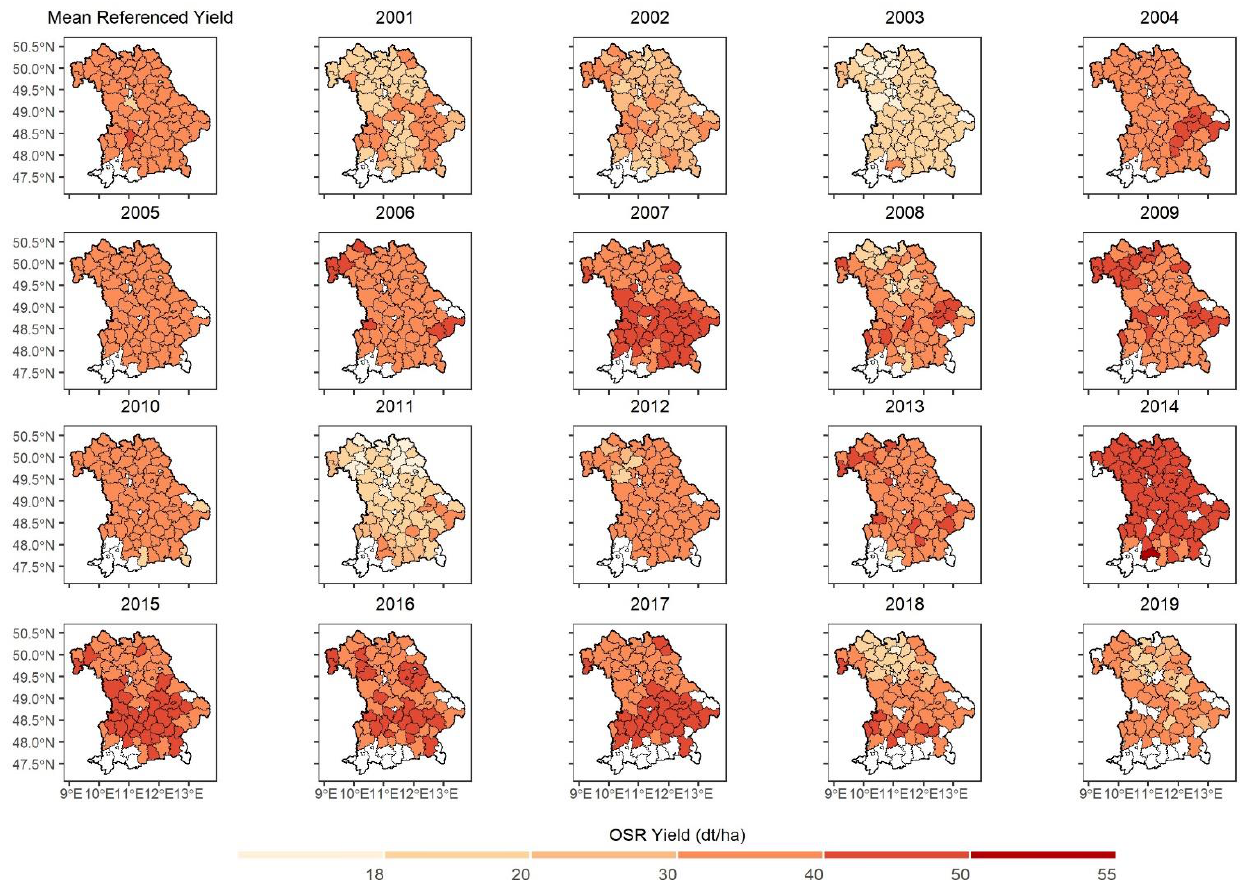
Figure 11. Spatial distribution of mean referenced yield (2001–2019) and the year-wise predicted yield for OSR from 2001 to 2019 using the LUE model for the state of Bavaria. The white colour represents no available data. A detailed map of the administrative regions of Bavaria is shown in Figure A1.